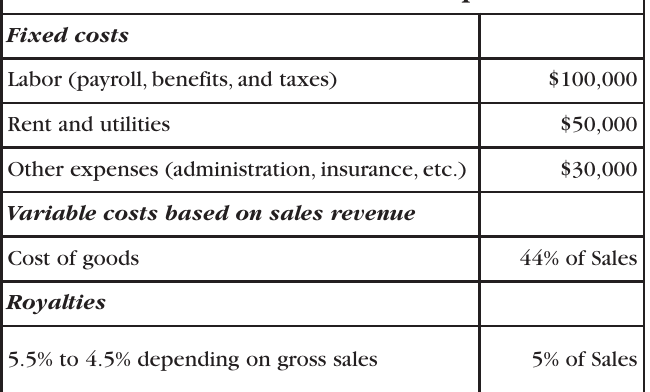
Table 5. Estimated Annual Costs per